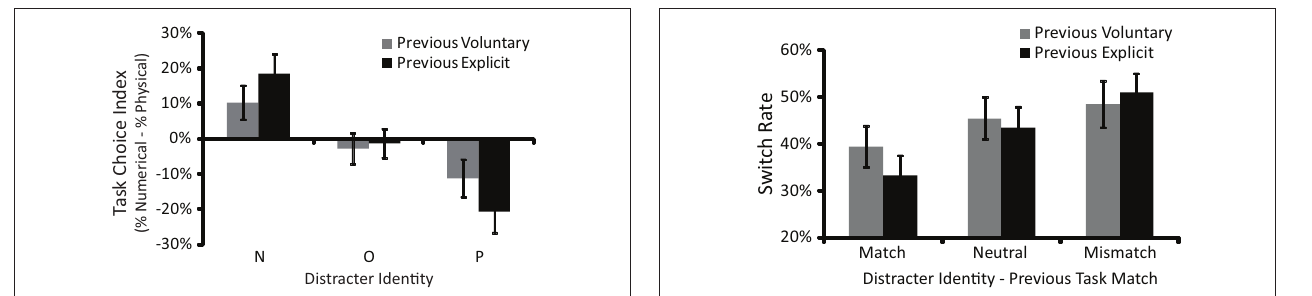
Figure 2 | The task choice index (i.e., the proportion of trials in which participants voluntarily chose the numerical size comparison task minus the proportion of trials in which they voluntarily chose the physical size comparison task) as a function of distracter identity (N, P, or O) and previous agency (voluntary, explicit). Positive values indicate a bias to choose the numerical size comparison task more often than the physical size comparison task. Negative values indicate the opposite bias. Participants tended to choose the task associated with the distracter letters (i.e., a positive task choice index for N distracters and a negative task choice index for P distracters) and this bias was stronger after explicit than after voluntary task choice trials. Error bars represent 95% confidence intervals.